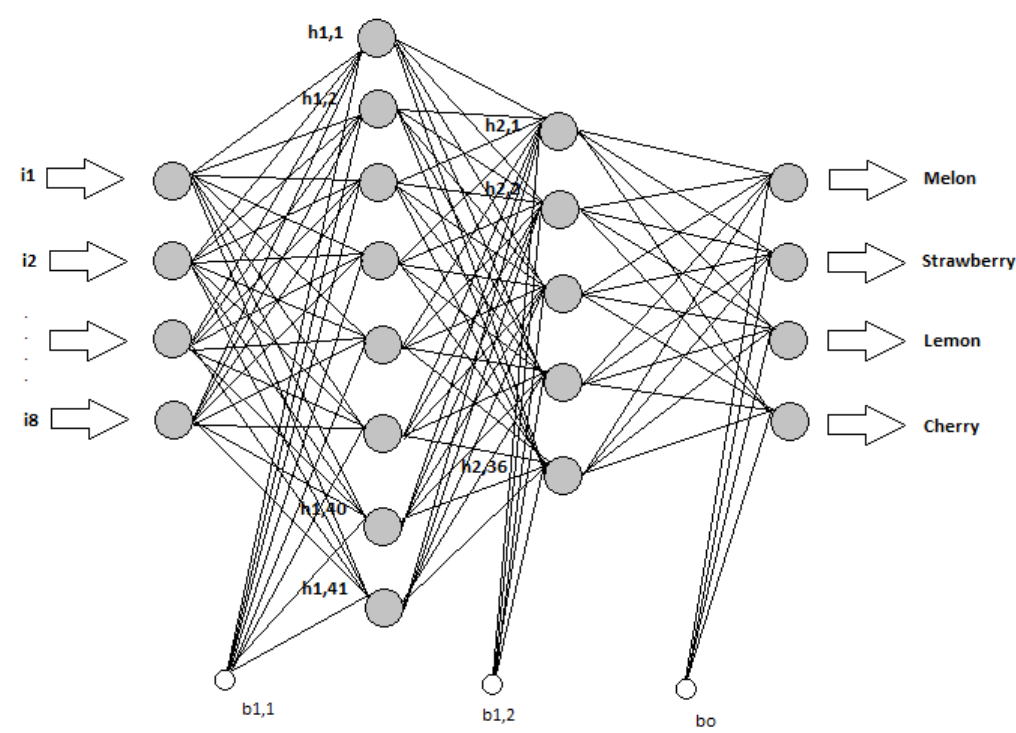
Figure 3. Structure of the artificial neural network (ANN) model used in the study.